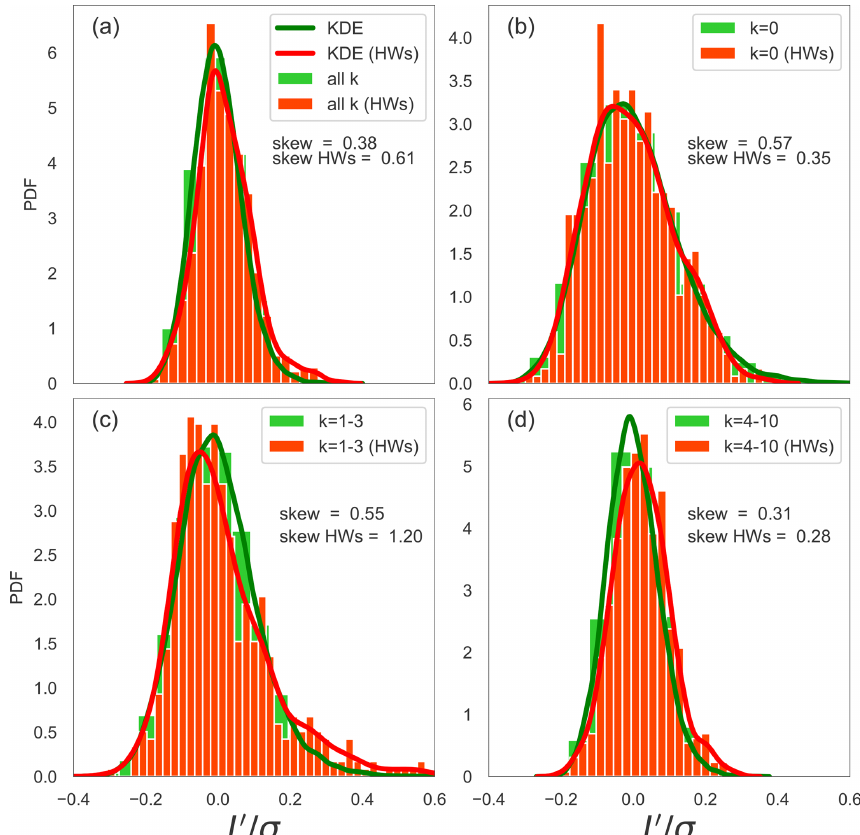
Figure 6. As in Fig. 4, but for the Eurasian heat waves listed in Table